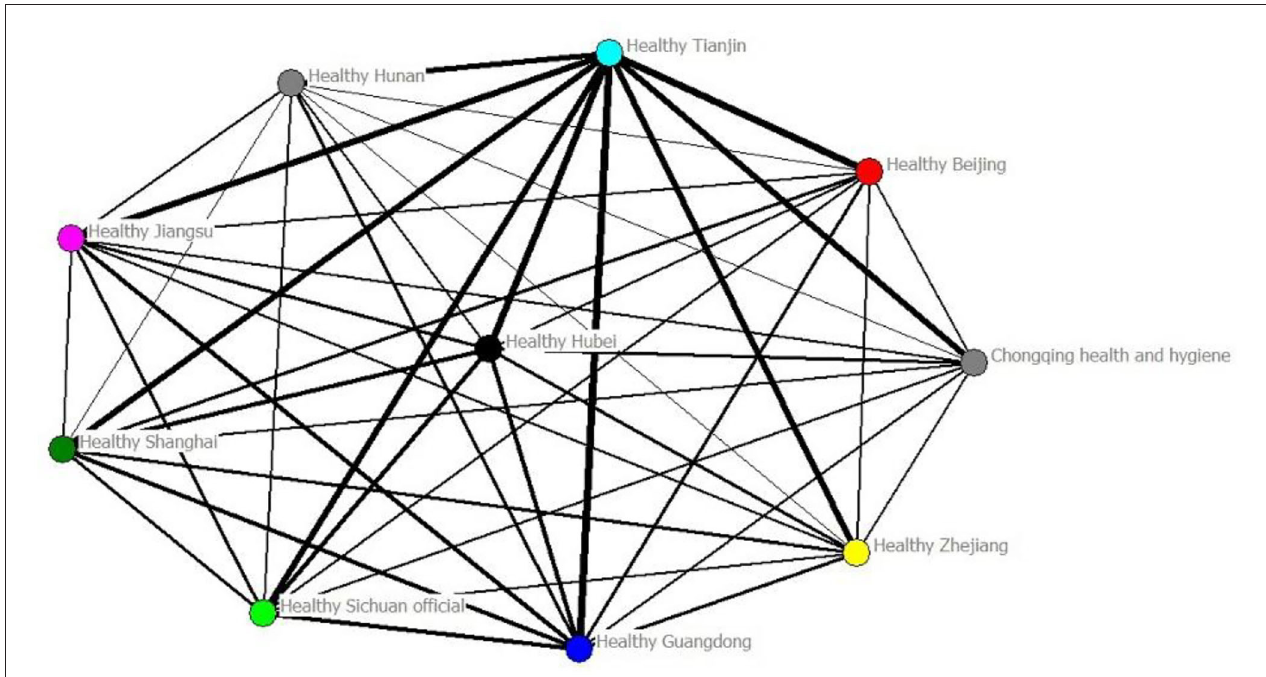
FIGURE 5 | Similarity-based visualization mapping of WeChat official account independence networks.